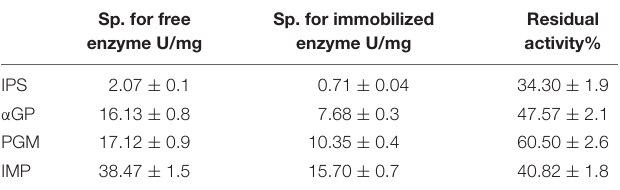
TABLE 1 | Relative activity of each enzyme before and after immobilization.